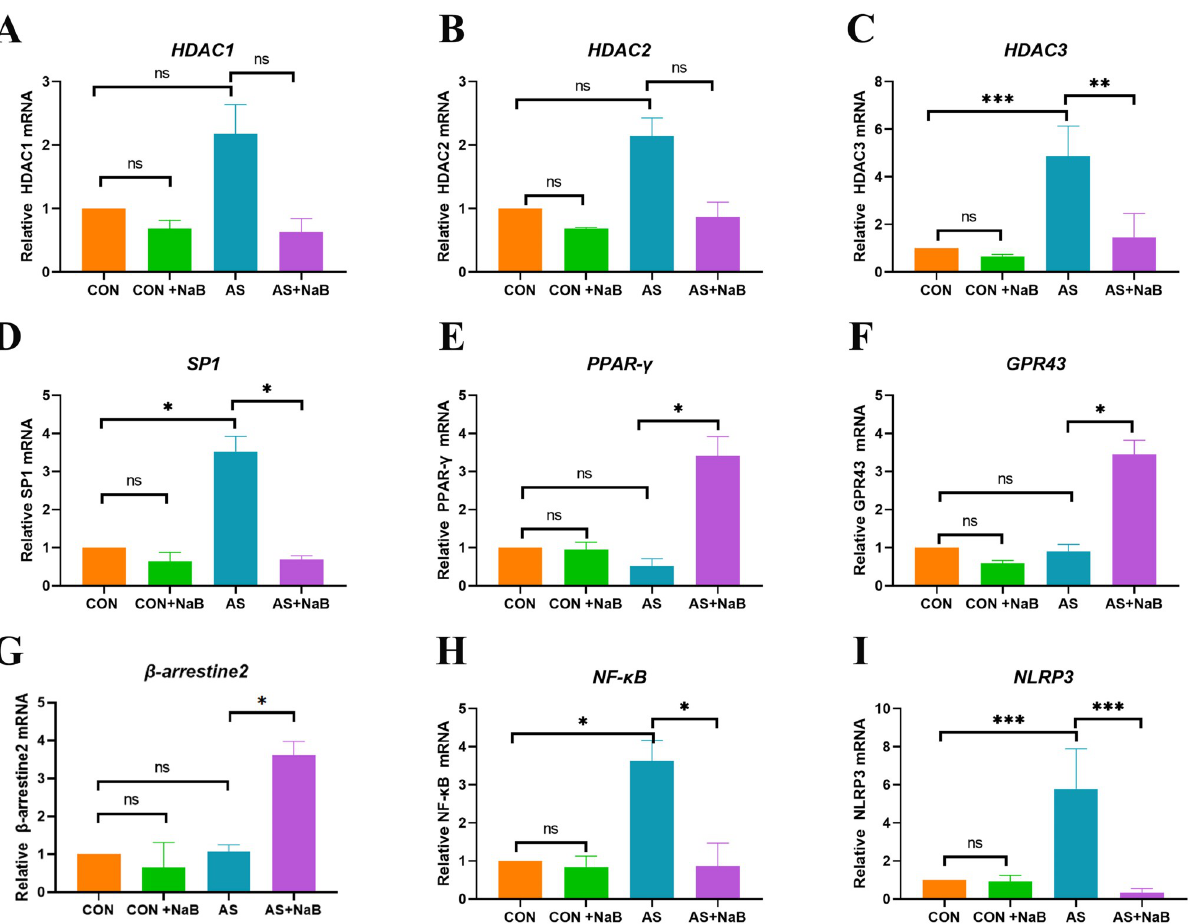
Fig 5. NaB inhibited inflammation via GPR43 and HDAC mediated pathway. RT-PCR was used to determine relative mRNA levels of HDAC1 (A); HDAC2 (B); HADC3 (C); Sp1 (D); PPAR- γ (E); GPR43 (F); β -arrestin-2 G); NF- κ B (H) and NLRP3 (I) in aorta tissues. � P < 0.05, �� P < 0.01, ��� P < 0.001. ns, no significant